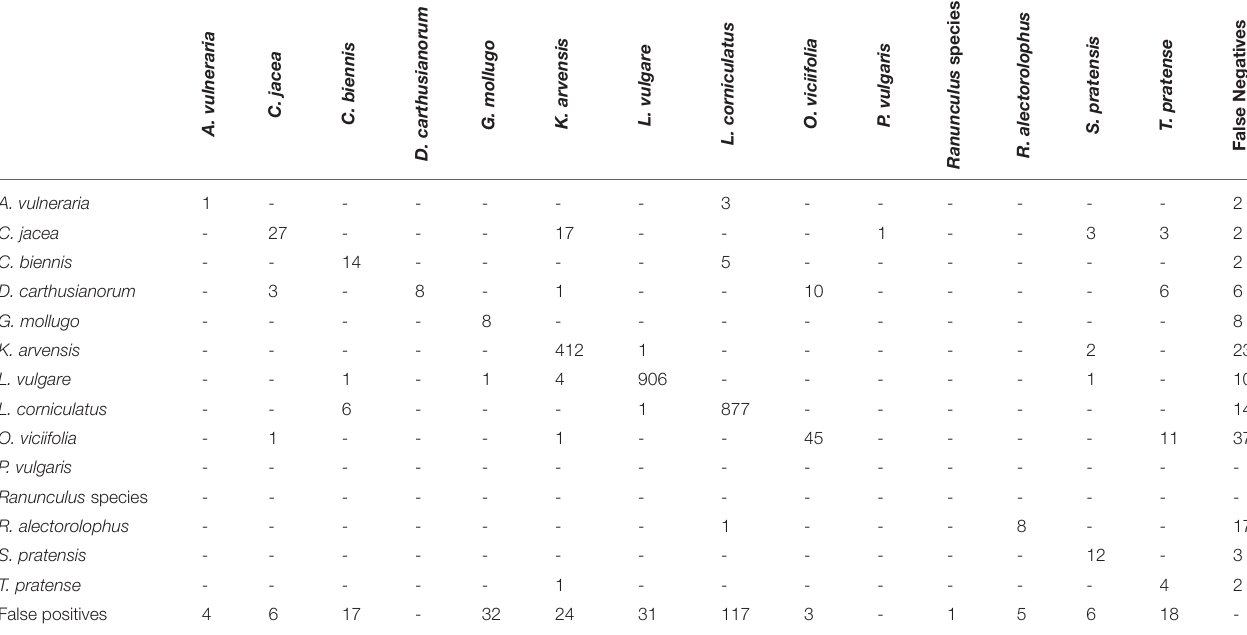
TABLE 3 | The table shows the confusion matrix.